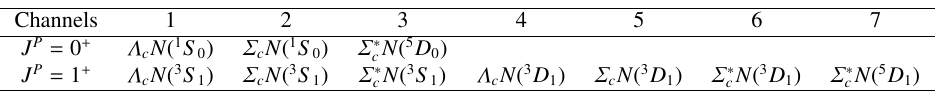
Table 1. The S -wave Λ c N states and the channels which couple to